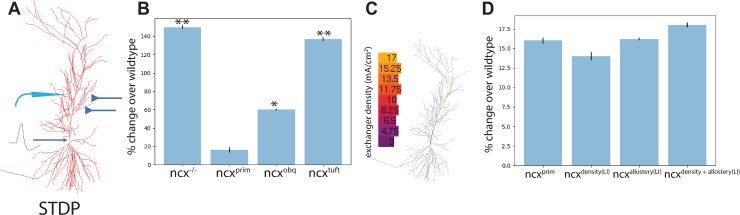
Removal of the Na+/Ca2+ exchange current increases potentiation.(A) STDP paradigm described previously [14] was used to pair back propagating action potentials with EPSPs to simulate potentiation at the synapse. (B) Potentiation of the synapse was examined in the absence of the Na+/Ca2+ exchange current (ncx-/-), when the Na+/Ca2+ exchange current is localized only to the primary dendrite (ncxprim), when the Na+/Ca2+ exchange current is localized the oblique dendrite region (ncxobq), or when the Na+/Ca2+ exchange current was localized to the tuft dendrite region (ncxtuft). (C) Graphical heatmap representation of the linear increase of the Na+/Ca2+ exchange current along the primary dendrite. (D) Comparison of STDP responses from the Na+/Ca2+ exchange current localized only to the primary dendrite (ncxprim) against linear models of NCX density (ncxdensity(LI)), allostery (ncxallostery(LI)), and density plus allostery (ncxdensity+allostery(LI)) along the primary dendrite. ** indicates p < 0.005 * indicates p < 0.05.